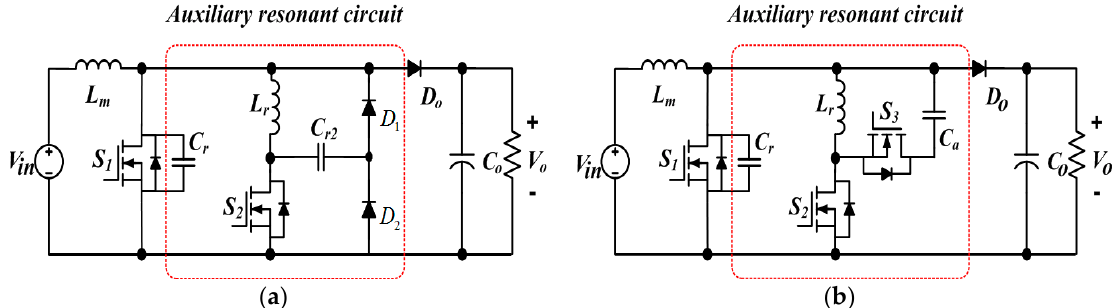
Figure 1. ( a ) Conventional zero voltage transition (ZVT) resonant boost converter and ( b ) proposed ZVT resonant boost converter.